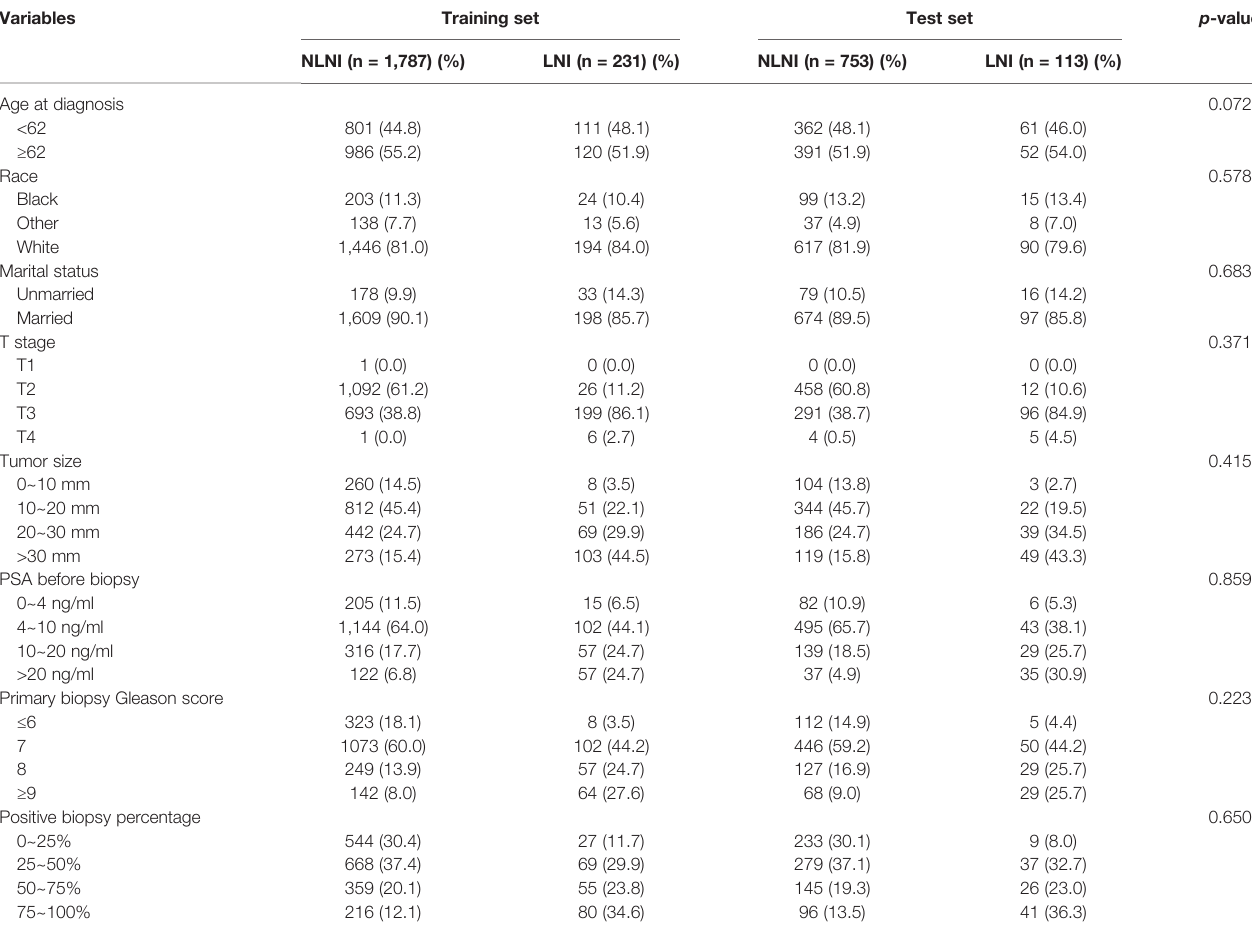
TABLE 1 | Clinical and pathological characteristics of the training and test